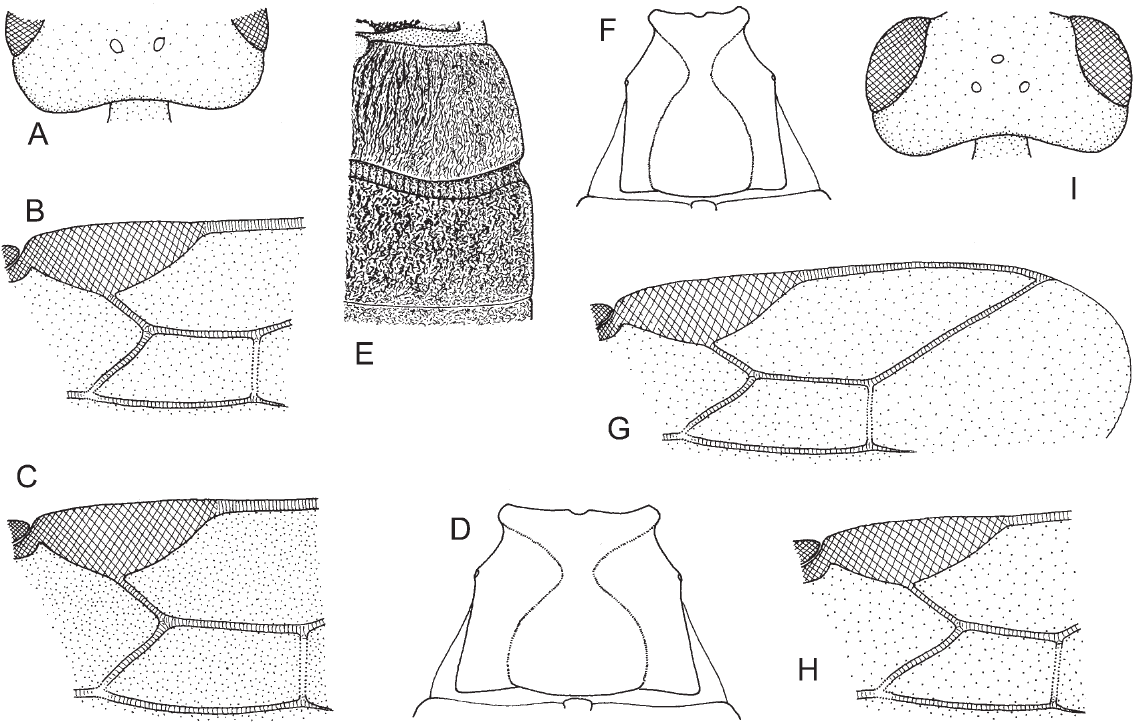
Fig. 25. — A-F . Bracon ( Bracon ) nigratus Wesmael, 1838 (A-C, E: ♀ / ♂, D: ♀, F: ♂). A . Temple and occiput in dorsal view. B-C . Middle part of right forewing: pterostigma and second submarginal cell. D . First tergite. E . Right half of tergites 2-3. F . First tergite. — G-I . Bracon ( Bracon ) variegator Spinola, 1808, ♀ / ♂. G . Distal part of right forewing. H . Middle part of right forewing: pterostigma and second submarginal cell. I . Head in dorsal